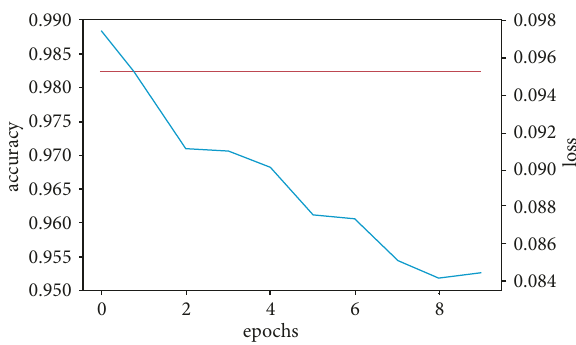
Figure 11: CNN model one accuracy and